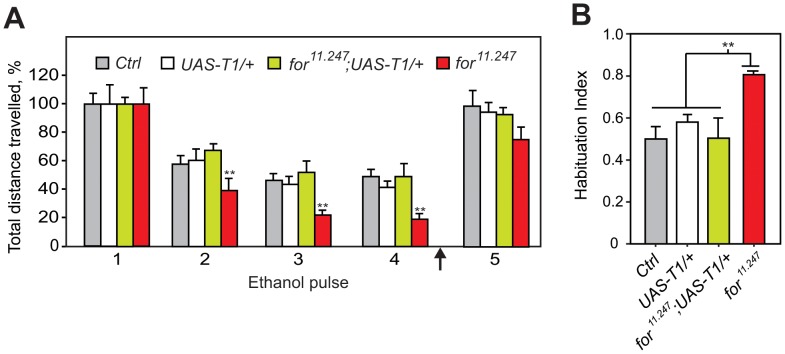

for11.247 -GAL4 flies expressing for-T1 have normal olfactory startle habituation.
A) Habituation profile of functional rescue of for11.247-GAL4 by expressing UAS-for-T1. No significant difference in distances travelled were seen between for11.247-GAL4;UAS-for-T1/+ and either Ctrl or UAS-for-T1/+. At pulse 2, 3 and 4, a significant difference was only seen between for11.247–GAL4;UAS-for-T1/+ and for11.247 (p<0.01; n = 12). B) HI of for
11.247 rescue. No significant differences were seen between for11.247-GAL4;UAS-for-T1/+ and either Ctrl or UAS-for-T1/+, but were observed between for11.247-GAL4;UAS-for-T1/+ and for11.247 (p<0.01; n = 12).